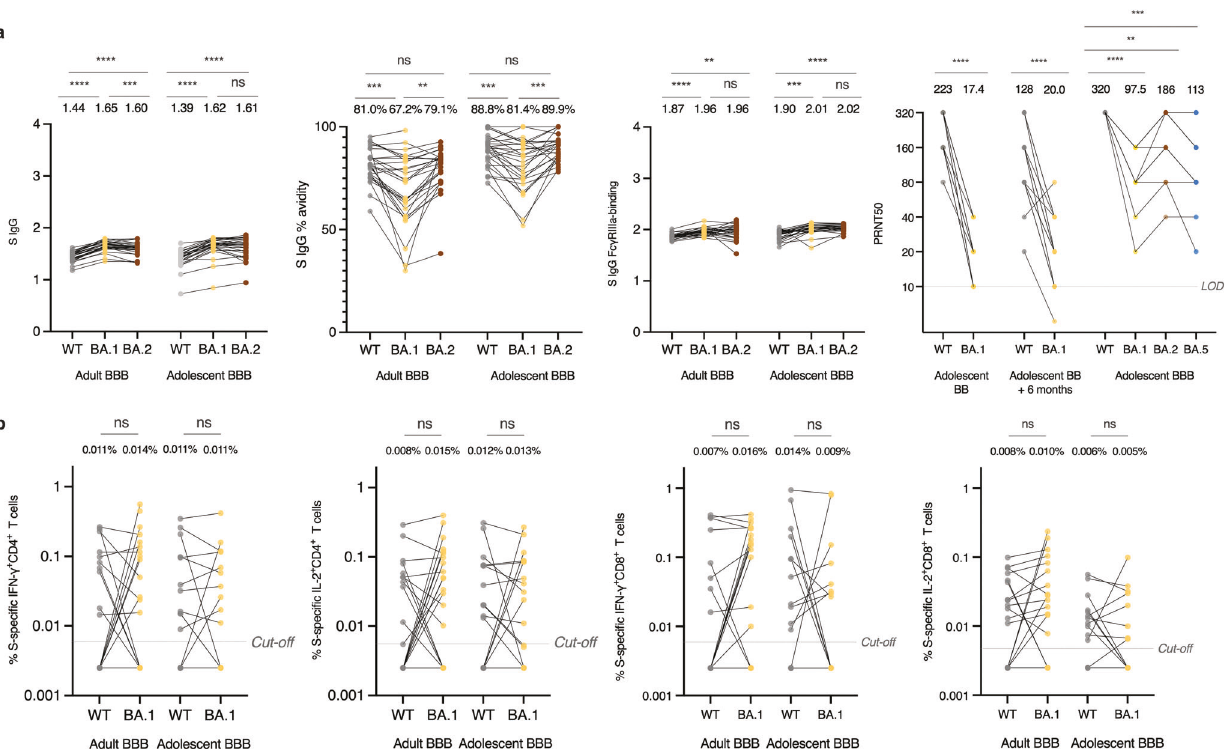
Fig. 3 Humoral and cellular immunity is maintained against WT, Omicron BA.1 or BA.2, or BA.5 after the third dose of the BNT162b2 (BBB) vaccine in healthy evaluable adolescents and adults. a WT, BA.1, BA.2 and BA.5 SARS-CoV-2 Spike (S) IgG (Adult BBB N = 28, Adolescent BBB N = 28), S IgG avidity (Adult BBB N = 28, Adolescent BBB N = 28) and S IgG Fc γ RIIIa-binding (Adult BBB N = 28, Adolescent BBB N = 28) and PRNT50 (Adolescent BB N = 25, Adolescent BB + 6 months N = 25, Adolescent BBB N = 14) in evaluable adolescents and adults. Although antibody levels were quantitatively higher for BA.1 or BA.2 than WT, neutralisation was lower for BA.1, BA.2 or BA.5 than WT. b Omicron S WT reference pool and BA.1 mutation pool-speci fi c interferon- γ (IFN- γ ) + CD4 + (Adult BBB N = 28, Adolescent BBB N = 22), interleukin-2 (IL-2) + CD4 + (Adult BBB N = 28, Adolescent BBB N = 22), IFN- γ + CD8 + (Adult BBB N = 28, Adolescent BBB N = 22), and IL-2 + CD8 + (Adult BBB N = 28, Adolescent BBB N = 22) T cells in evaluable adolescents and adults. The cellular responses were similar between WT and BA.1. Data labels and centre lines show geometric means (GM) estimates, with corresponding 95% con fi dence intervals shown by error bars. Dots representing the same participants are linked by a straight line. Statistical analysis was determined using paired t -test after natural logarithmic transformation with p values denoted. ** p < 0.01, *** p < 0.001, **** p < 0.0001. ns not signi fi cant. LOD limit of detection, WT wild-type, Fc γ RIIIa Fc γ receptor IIIa, PRNT plaque reduction neutralisation test. Cut-offs were drawn as grey